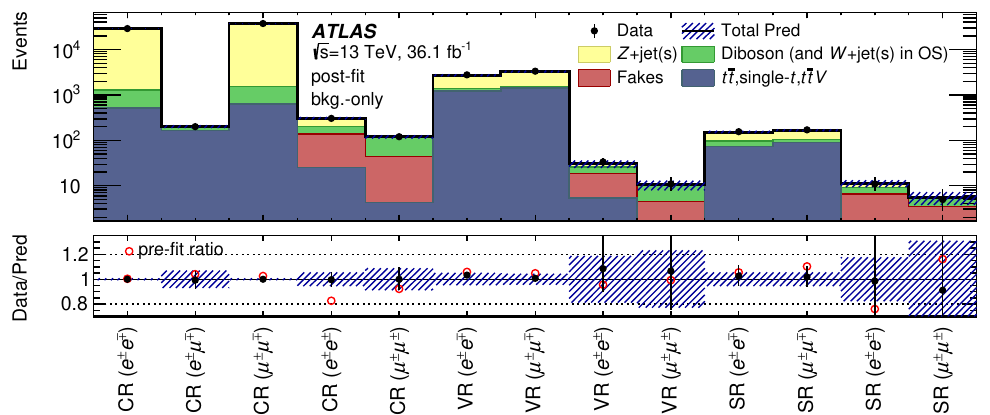
Figure 3 . Number of observed and expected events in the control (CR), validation (VR), and signal (SR) regions for all channels considered after the background-only (cid:12)t. The background expectation is the result of the (cid:12)t described in the text using both OS and SS control regions. The hatched bands include all post-(cid:12)t systematic uncertainties. The correlation between sources of systematic uncertainties are taken into account. The pre-(cid:12)t ratio is indicated with the red hollow markers in the ratio